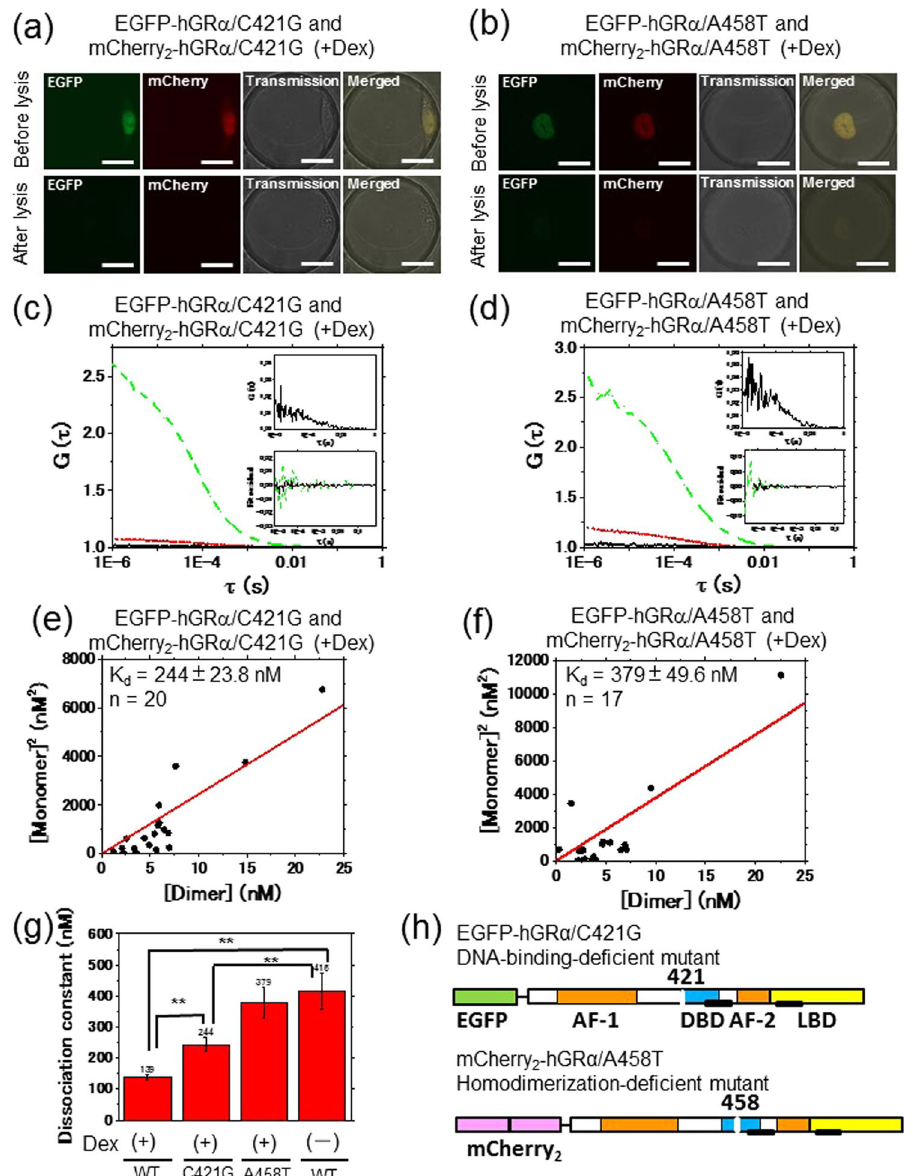
Figure 2. Determination of in vitro K d of GR α mutants using the FCCS-microwell system. Typical auto- and cross-correlation curves constructed by measurements in microwells after lysis of U2OS cells coexpressing EGFP-hGR α mutants and mCherry 2 -hGR α mutants in the presence of Dex. The green dashed line, red dotted line, and black solid line denote the autocorrelation of the green channel [ G G ( τ )], autocorrelation of the red channel [ G R ( τ )], and cross-correlation [ G C ( τ )], respectively. The insets show an enlarged graph of the cross- correlation curve and fitting residuals of autocorrelation and cross-correlation curves. LSM images of U2OS cells coexpressing EGFP-hGR α mutants and mCherry 2 -hGR α mutants before and after cell lysis in a microwell for the C421G mutant ( a ) and A458T mutant ( b ). The scale bar is 20 μ m. FCCS was performed in a microwell after cell lysis for the C421G mutant ( c ) and A458T mutant ( d ) in the presence of Dex. ( e, f ) Results of K d determination using a scatter plot and linear regression. The plots represent the square of the concentration of the monomeric hGR α versus the concentration of the dimer of hGR α . The solid red line shows the linear fit. The slope indicates K d . ( e ) The C421G mutant in the presence of Dex. ( f ) The A458T mutant in the presence of Dex. ( g ) A summary of in vitro K d values determined using the FCCS-microwell system. WT: wild type, C421G: the C421G mutant, A458T: the A458T mutant. Statistical analysis was based on ANOVA ( ** p < 0.01) ( h ) A schematic diagram of mCherry 2 - and EGFP-fused constructs of mutated hGR, C421G (DNA-binding-deficient mutant) and A458T (homodimerization-deficient